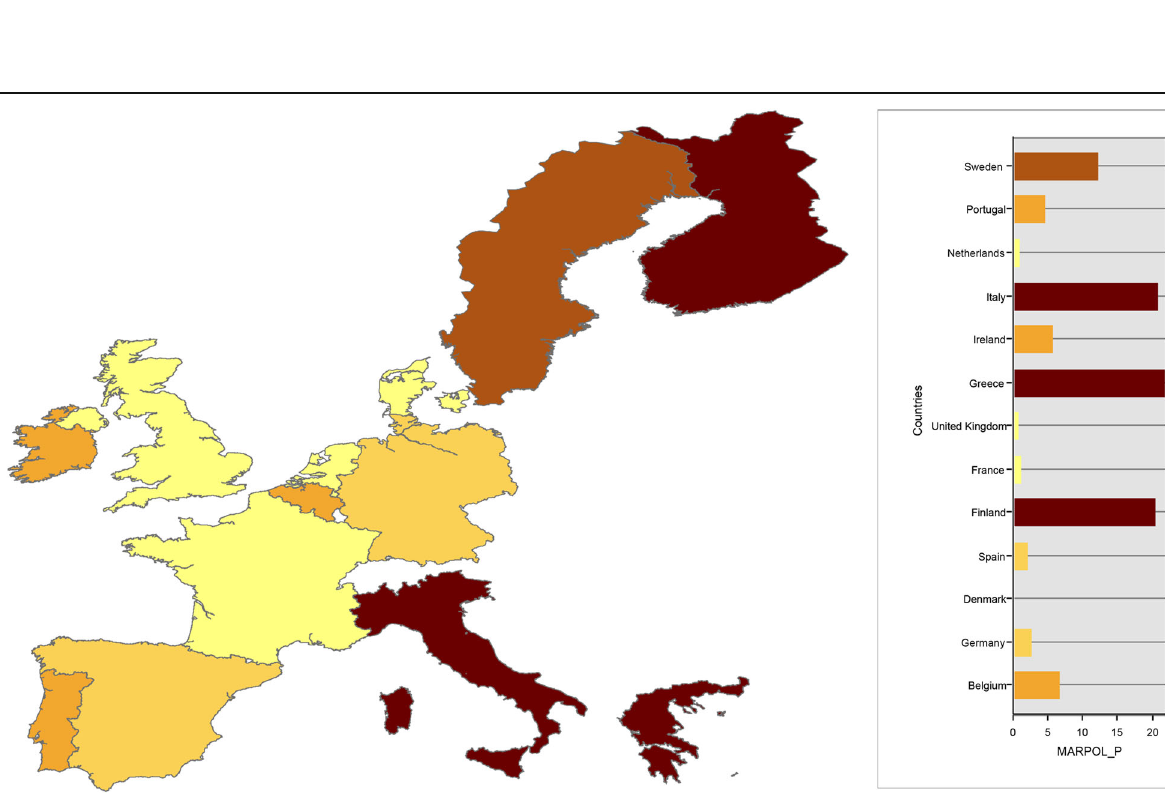
Fig. 16 Detainable remarks percentage for MARPOL Convention for EU15